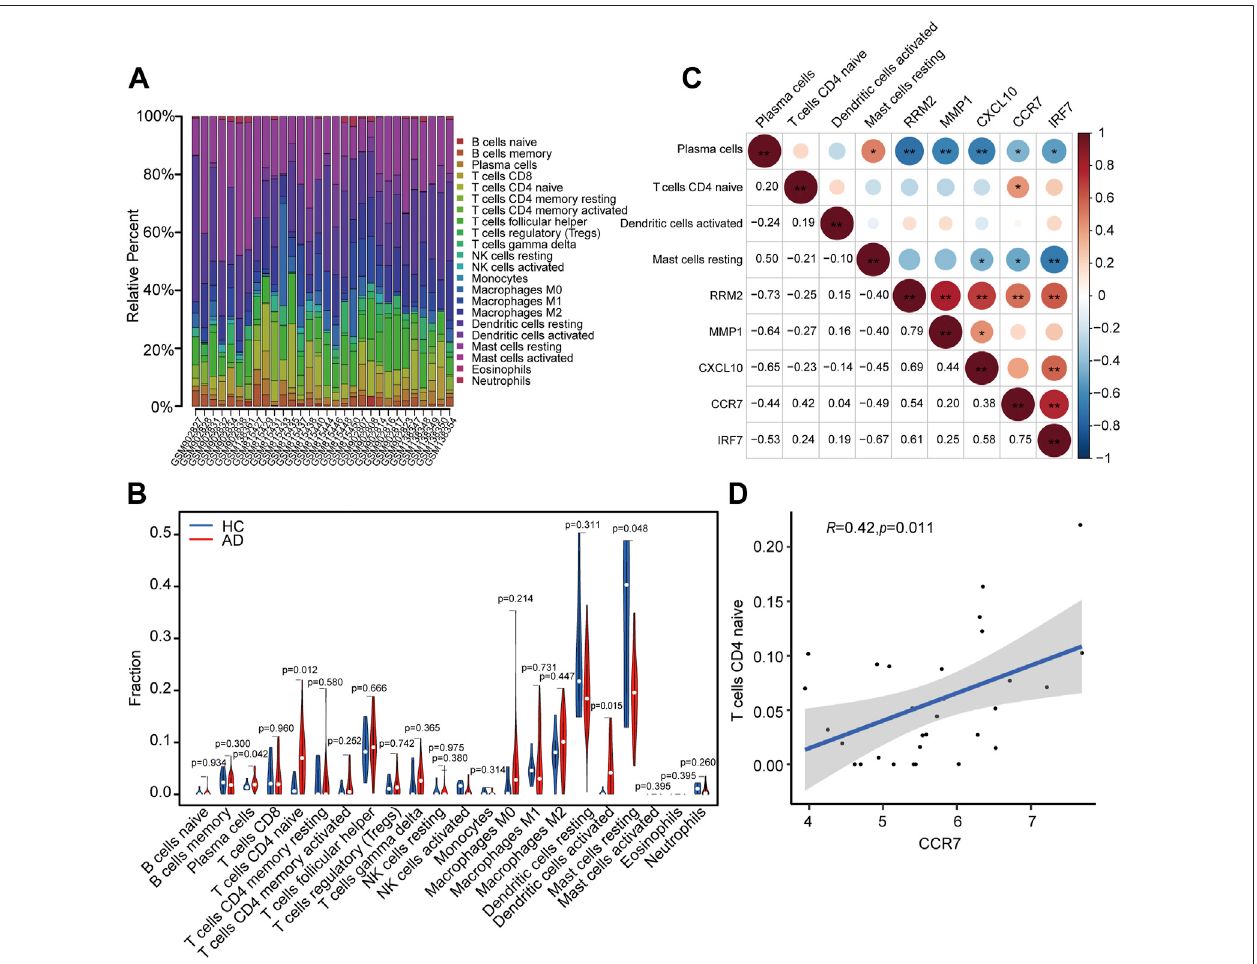
FIGURE 9 | Analysis of immune cell in fi ltration and the relationship of hub genes with differential immune cells in individuals with AD. (A) Relative fraction of 22 sub- populations of immune cells in AD samples. (B) The differences of 22 sub-populations of immune cells among the AD and HC tissues. (C) Correlation among four remarkable differential immune cells and fi ve identi fi ed hub genes. (D) Remarkably related hub genes and immune cells screened by the criteria R > 0.4 and p < 0.05.